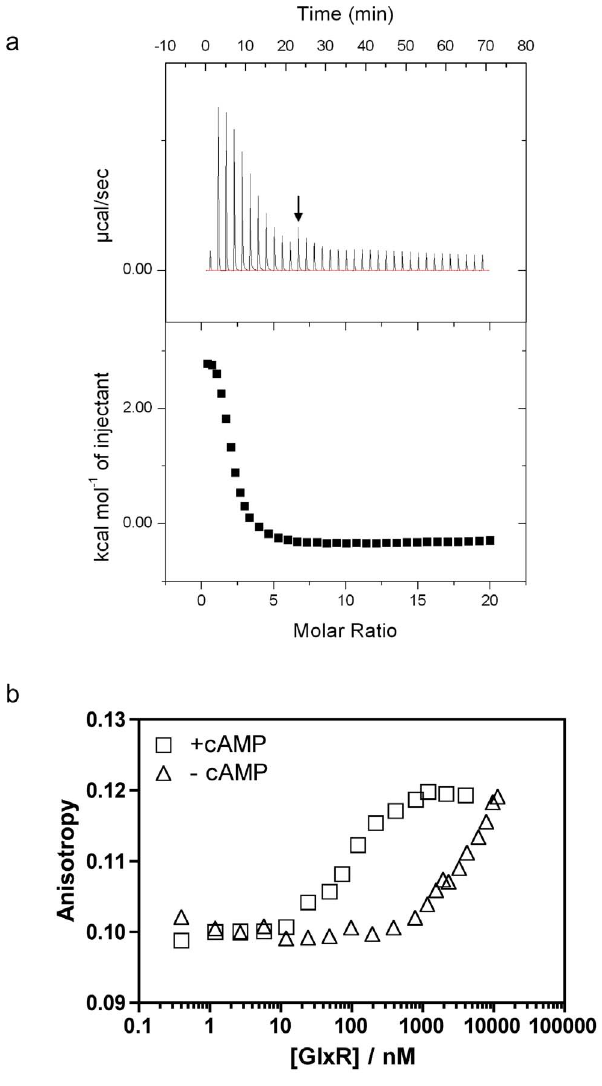
Figure 4. Biophysical Characterisation of co-factor and DNA binding of Cg-GlxR. a) Isothermal titration calorimetry traces (upper panel) and binding isotherms (lower panel) for the titration of cAMP to Cg-GlxR. The arrow indicates the switch from 0.5 m l to 1 m l injections. K D1 5 1.7 ? 10 2 5 mol/l; K D2 5 1.3 ? 10 2 4 mol/L. b) DNA- binding: Fluorescence Anisotropy data showing the cAMP dependent DNA